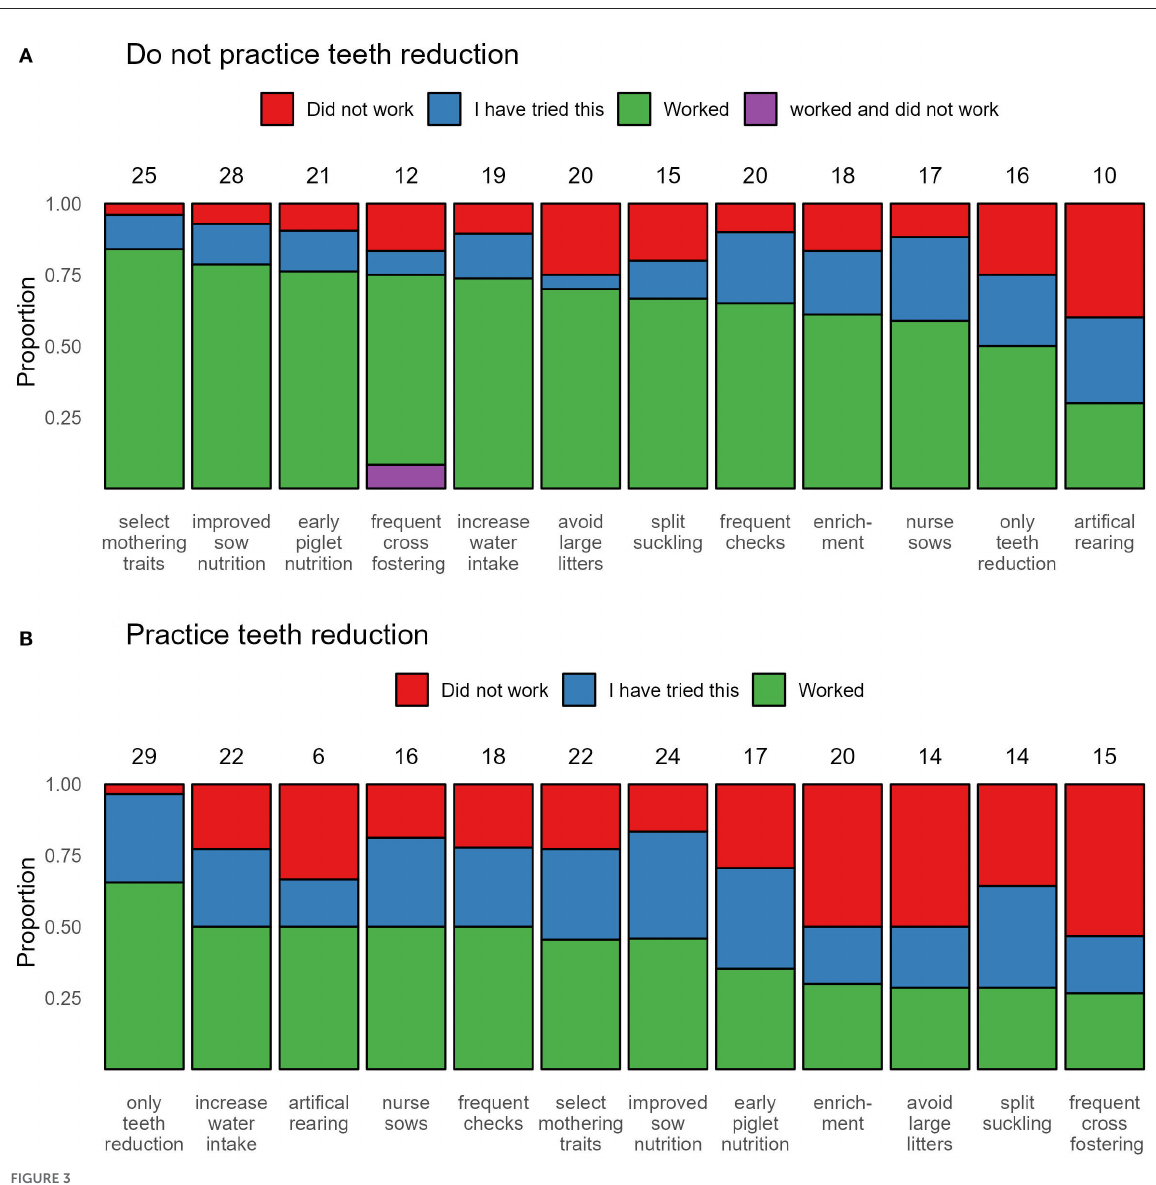
FIGURE3 Reported measures to prevent piglet facial and sow teat lesions varied between the two groups of respondents (with or without performing teeth reduction). Counts of the total number of respondents who tried each measure are shown above the bars. (A) Do not practice teeth reduction. (B) Practice teeth